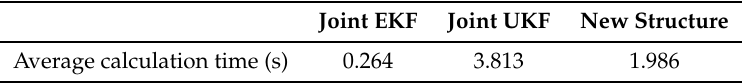
Table 2. Computation efficiency of the new proposed monitoring